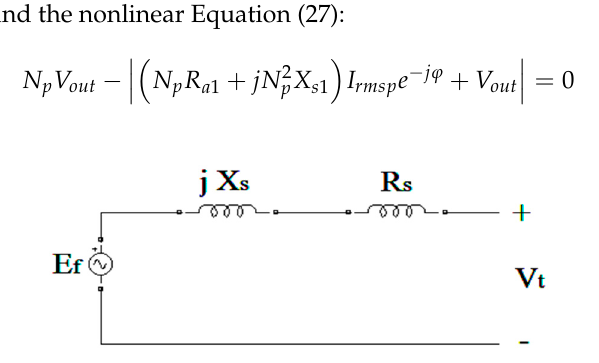
Figure 8. Equivalent electric circuit of the machine’s synchronous non-salient pole.